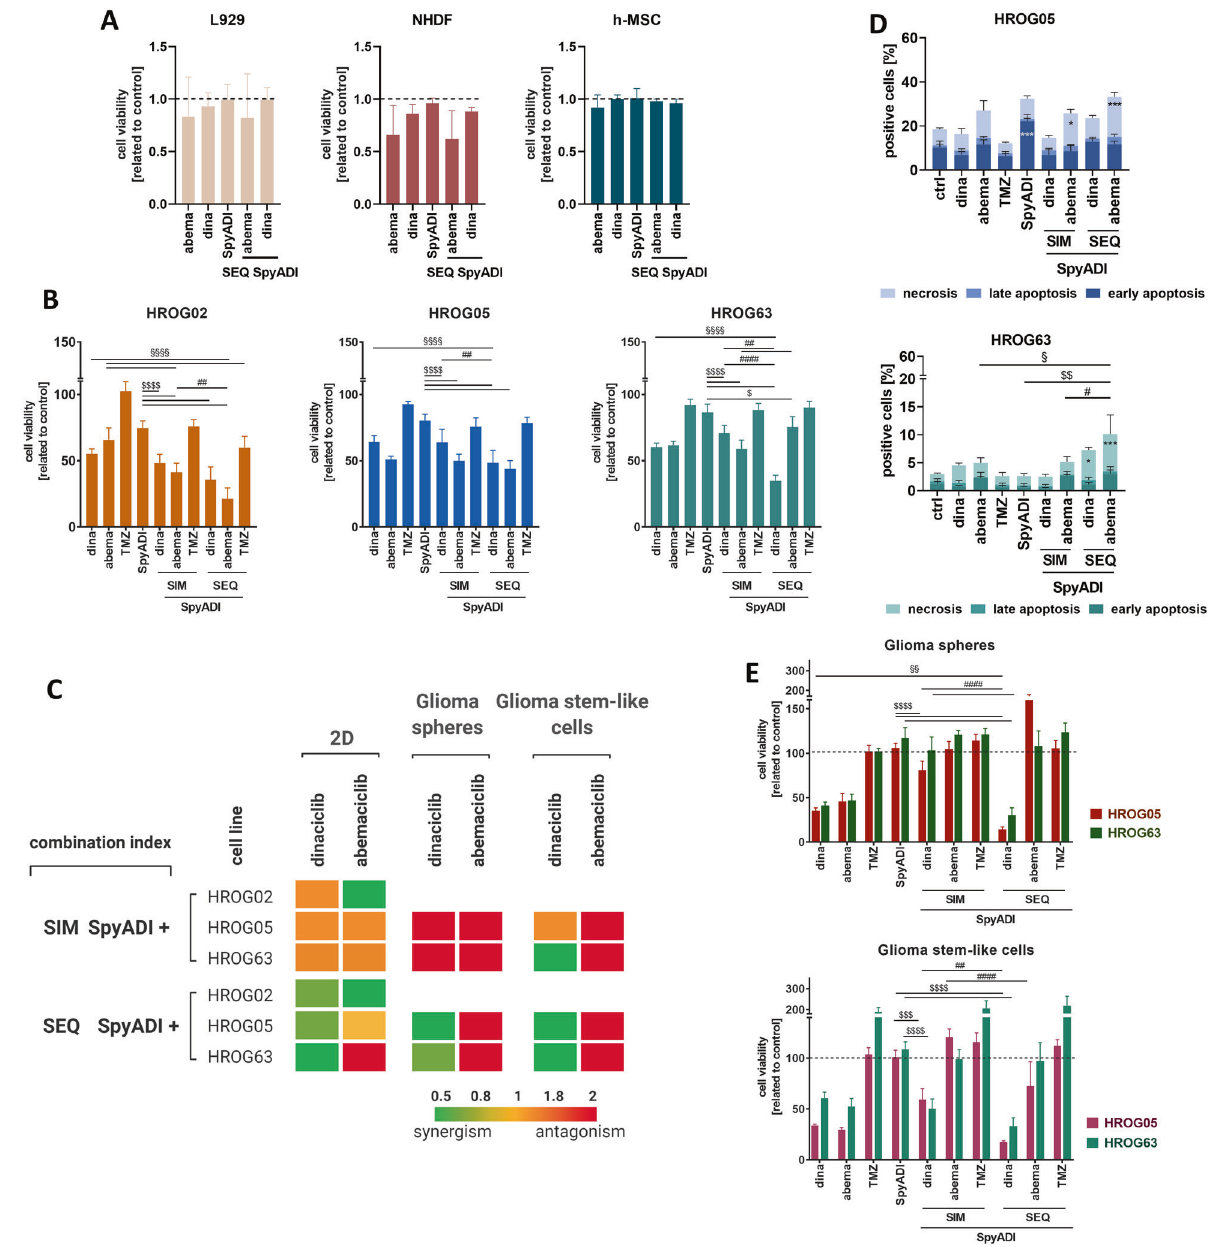
Fig. 1 Viability and cytotoxicity assays after mono- and combination therapy using different settings and experimental conditions. A Viability of non-malignant control cells. Cells (L929, NHDF, and h-MSCs) were treated with the respective substances for 2 × 72 h in a sequential treatment regimen (SEQ). Quantitative analysis was done using Calcein AM assay. n = 3 independent experiments. B – E GBM cells were treated with the respective substances for 2 × 72 h in a simultaneous or sequential treatment regimen (SIM; SEQ). B Quantitative analysis of cell viability using Calcein AM in the 2D-model (HROG02, HROG05, HROG63). n = 8 independent experiments. C Bliss independence calculation. The Bliss independence model was applied to determine synergistic, additive or antagonistic effects based on the results obtained after 2 x 72 h treatment with the indicated substances. Interpretation is as follows: Δ < 1: synergism (green pattern); Δ = 1: additive (yellow pattern); Δ > 1: antagonistic (orange and red pattern). Image was created with Biorender.com. D Quantitative analysis of cytotoxicity was done via fl ow cytometry upon staining with Yo-Pro1 and PI. Cells were either characterized as early-apoptotic, late-apoptotic, or necrotic. n = 3 independent experiments; statistical differences were obtained for the necrotic cell fraction: * p < 0.05; *** p < 0.001; § p < 0.05; $$ p < 0.01; # p < 0.05. E Quantitative analysis of cell viability in the 3D systems (HROG05, HROG63) was done using 3D-Glo. B , E Viability reduction (%) after treatment was quanti fi ed by normalization to control values (untreated cells set to be 100 %). n = 8 independent experiments; §§ p < 0.01; §§§§ p < 0.0001; $ p < 0.05; $$$ p < 0.001; $$$$ p < 0.0001; ## p < 0.01; #### p < 0.0001. One-way